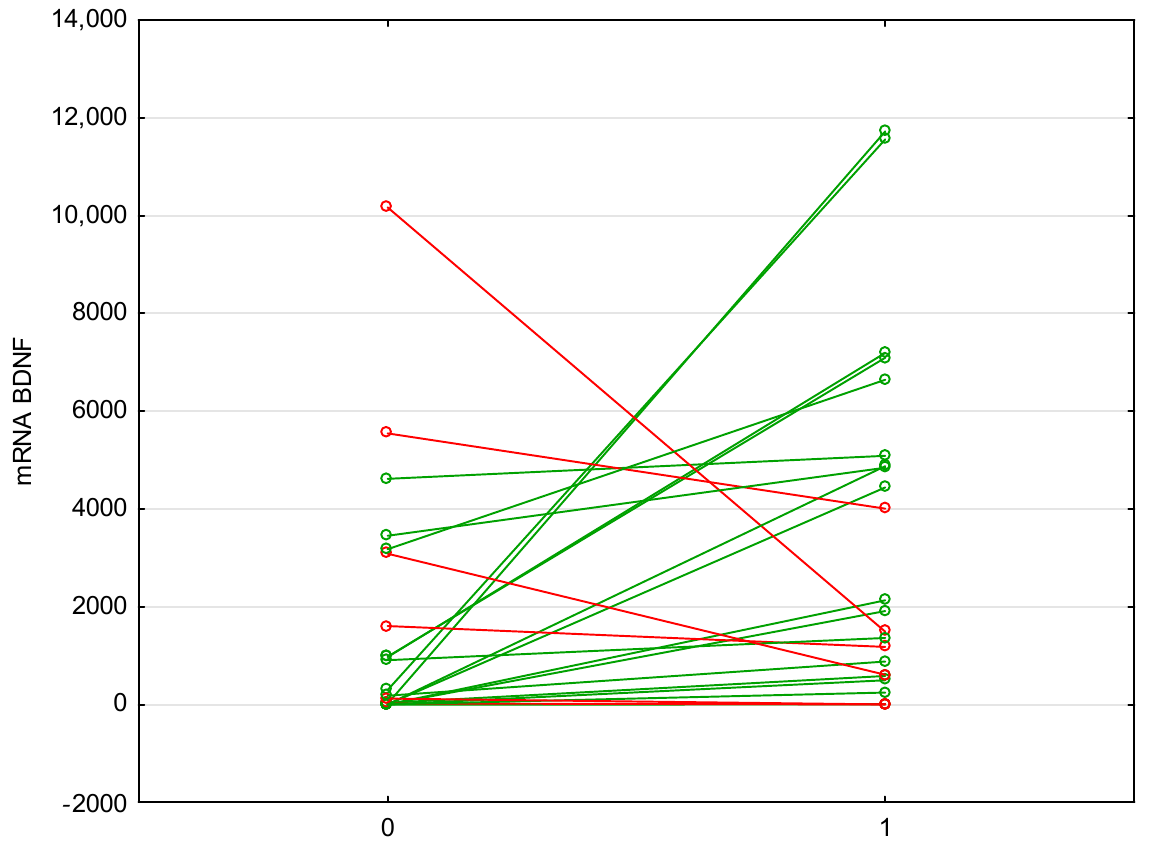
Table 6. Correlations between changes in neurotrophin expressions post anti-TNF therapy, ques- tionnaire scores, and sleep e ffi ciency.